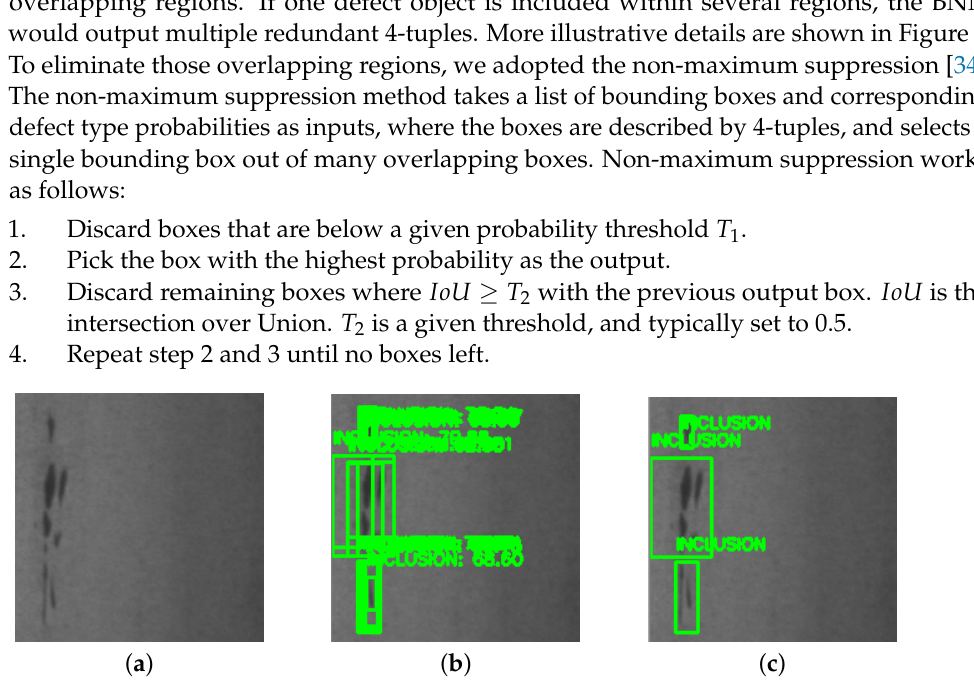
Figure 6. The results of non-maximum suppression algorithm: ( a ) describes the input image; ( b ) de- scribes the defects localization results without non-maximum suppression; and ( c ) describes the defects localization results with non-maximum